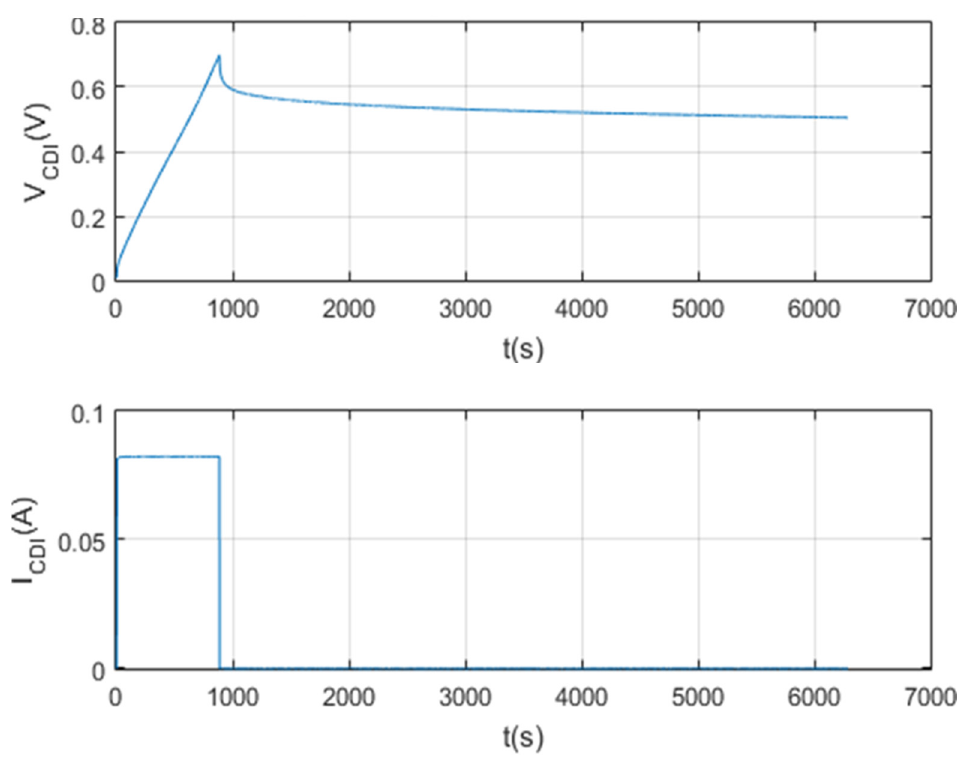
Figure 17. Graphs with details of the charge and self-discharge test, characterizing it on a 150 F capacitor.